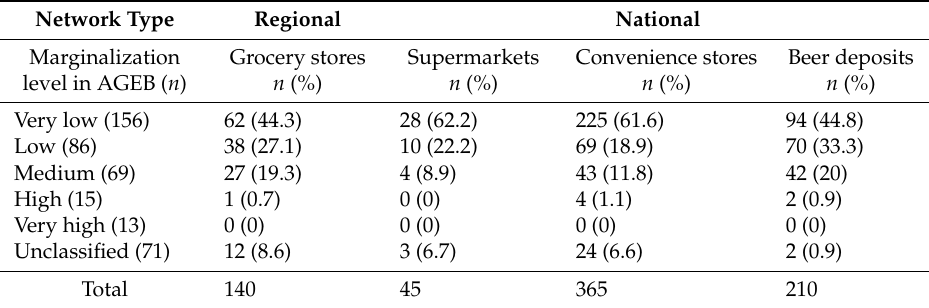
Table 1. Distribution of 760 food establishments by marginalization level ( n = 410 AGEB). Source: Own elaboration (2018), data obtained from INEGI